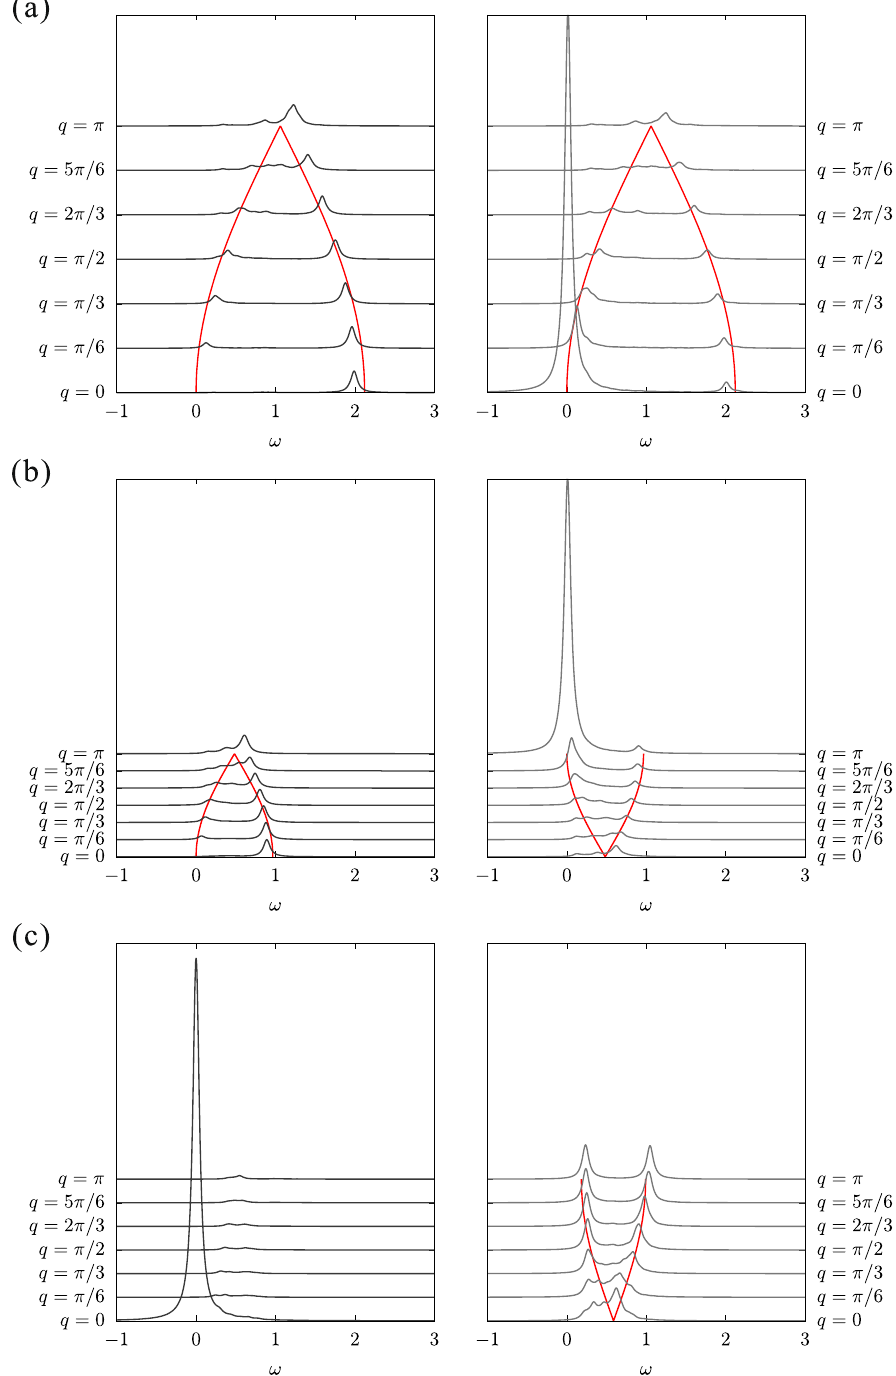
Figure 11. Dynamical structure factors calculated with a periodic 24-site chain for (a) FM- xy [ φ = π 5 staggered- xy [ φ = π 19 ], and (c) Néel- z [ φ = π 17 ] states. The left and right panels show S z ( q , ω ) and S − ( q , ω ), 12 10 respectively. The red lines are analytical dispersions: Eq. (42) for φ = π 5 , Eq. (43) in S z ( q , ω ) and Eq. (44) in 4 S − ( q , ω ) for φ = π 19 , and Eq. (45) for φ = π 17 12 10